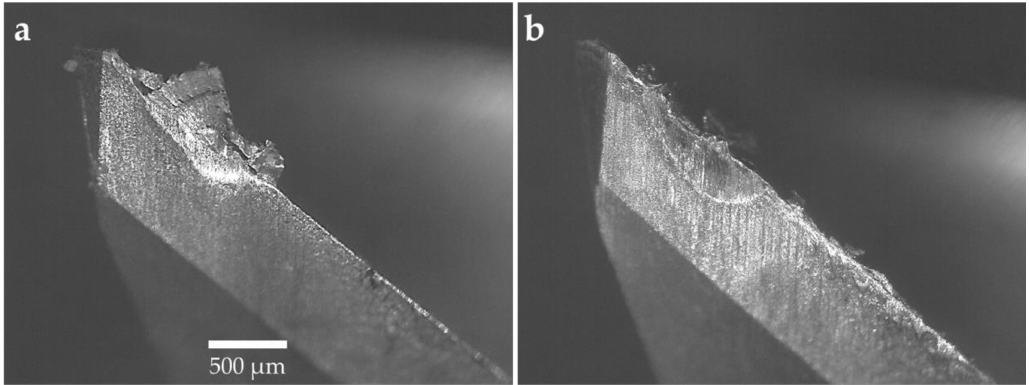
Figure 6. Micrographs of the tool with a 12 ◦ rake angle: ( a ) 10 ◦ primary clearance angle and ( b ) 8 ◦ primary clearance angle.